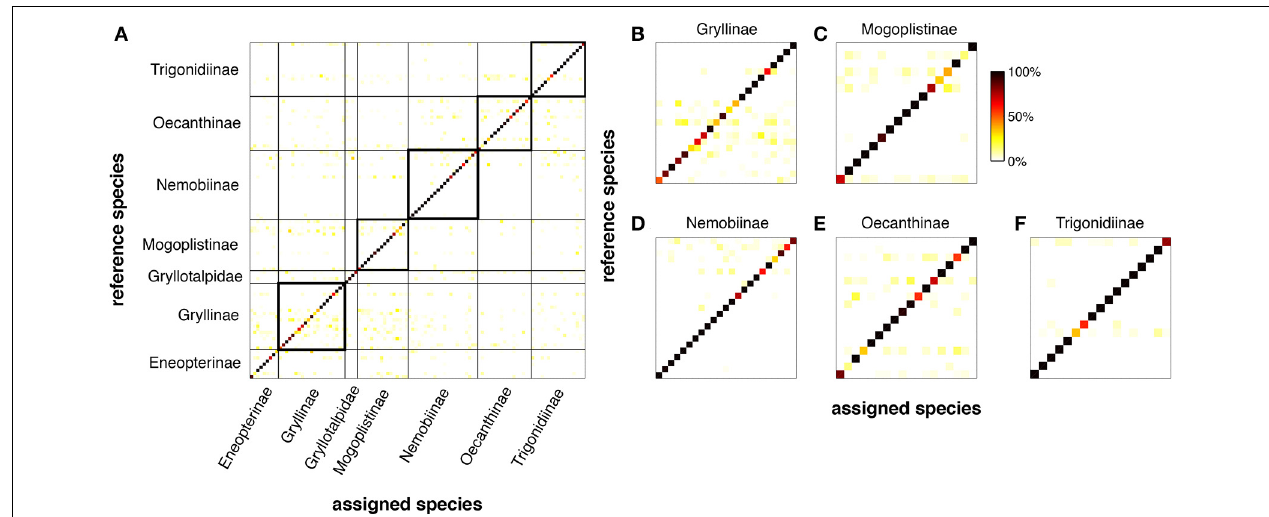
FIGURE 6 | LN-models discriminate the songs of 106 North-American species of crickets. For each species, we trained a model with two filter-nonlinearity pairs (see Figures 1 , 2 ) to discriminate its own song from all the other 105 songs using a Genetic Algorithm (cf. Clemens and Hennig, 2013). Each row in (A–F) depicts the normalized output values of each species’ model for all songs (color coded). Dark shading confined to the main diagonal indicates high specificity (i.e., phonotaxis scores) of the model